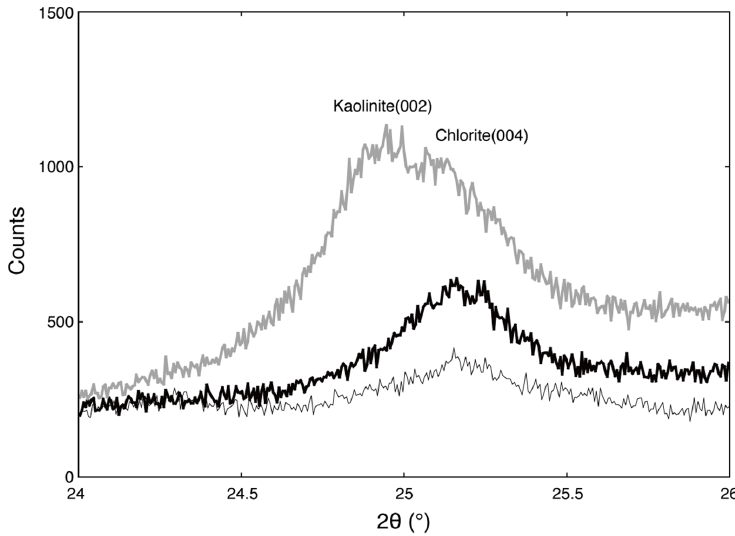
Figure 5. Representative kaolinite(002) and chlorite(004) peaks in the X-ray diffractograms (2 θ = 24–26°) of clay size in the ethylene-glycolated state from this study.